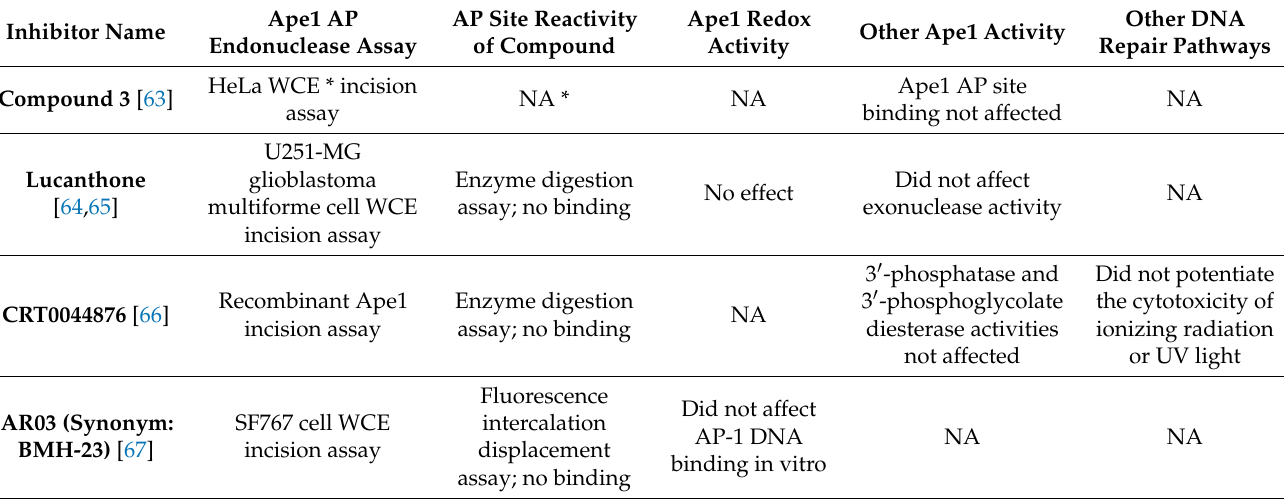
Table 1. Major Ape1 endonuclease inhibitors and their characteristics.